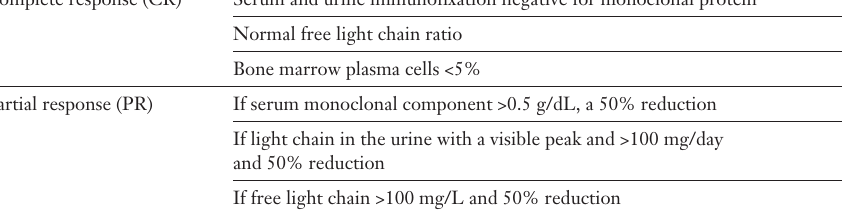
Table 2 Criteria for haemato- logical response